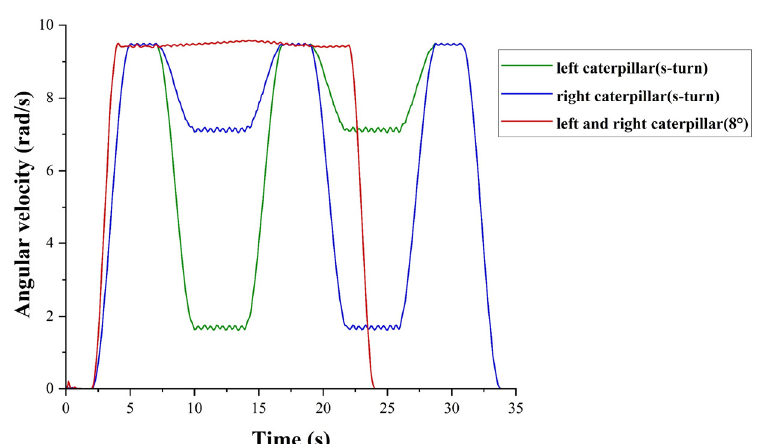
( b ) Figure 10. Details of field test site: ( a ) location of field experiment site, ( b ) two test lines in the field test. In the single frame experiment, the original frame was modified to simulate the ac- tual loading conditions. The mass of a single bee frame fully loaded with honey was ap- proximately 2.5 kg [14], and the mass of the empty bee frame was approximately 0.8 kg. Instead of using actual honey, the frames were modified with a pack of paper (1.7 kg) to